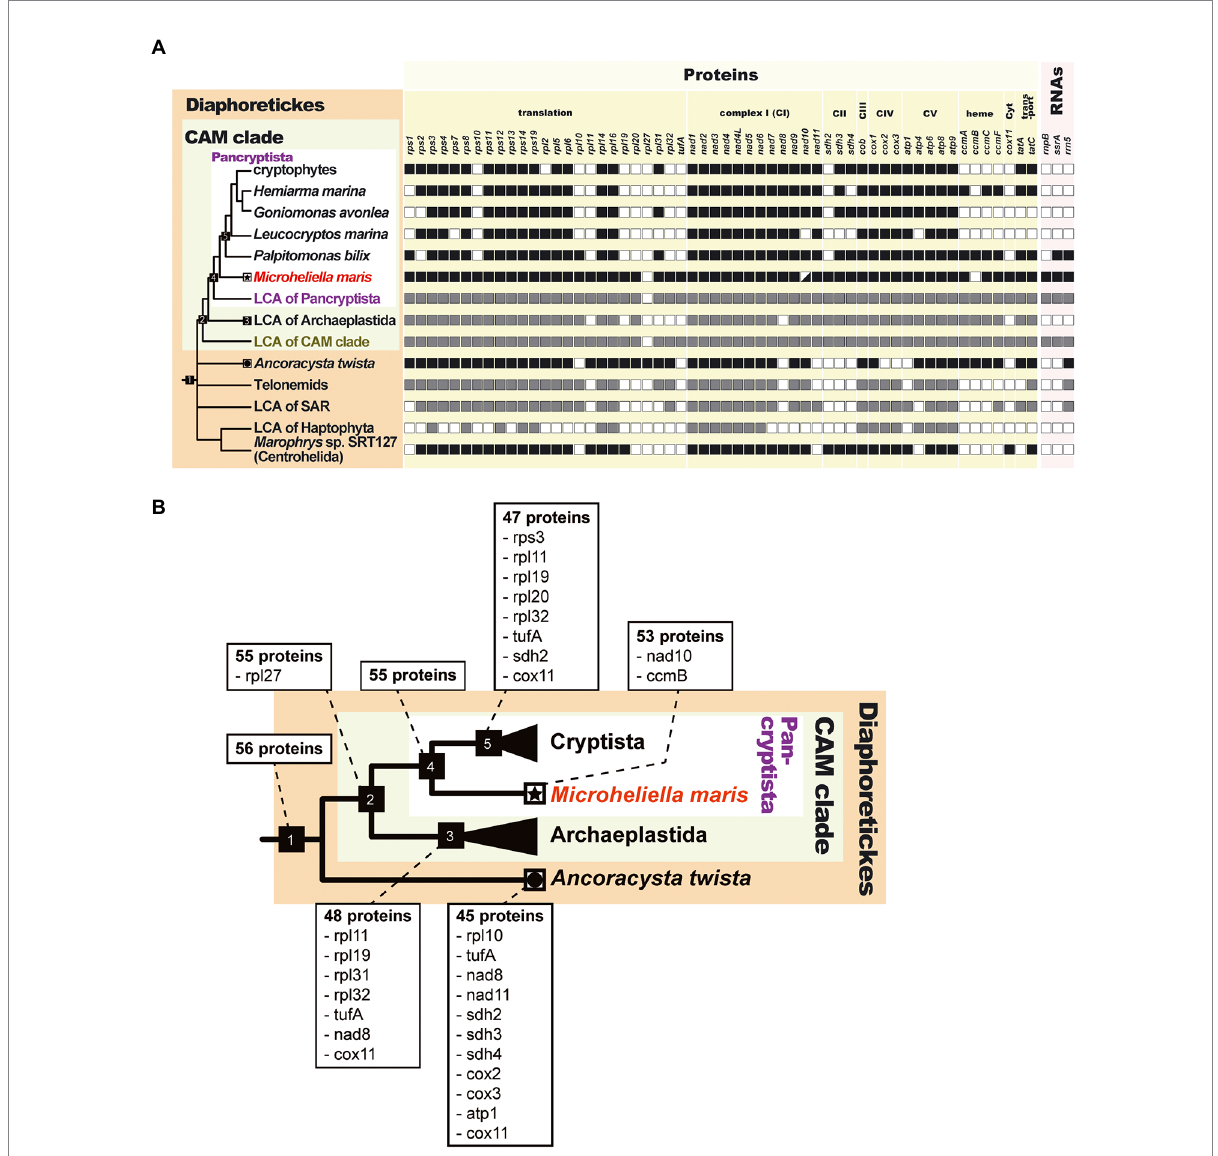
FIGURE 2 Evolution of mitochondrial genomes in Diaphoretickes. (A) Comparison of the gene contents of the mitochondrial genomes in Diaphoretickes. We only considered the genes containing functionally assignable open reading frames in this comparison. The presence and absence of genes in a mitochondrial genome are shown by closed and open squares, respectively. nad10 was absent in the mitochondrial genome but the corresponding transcript was detected in Microheliella maris (highlighted by a square with lower right half painted in black). The putative presence and absence of genes in the last common ancestors (LCAs) of Pancryptista, Archaeplastida, SAR, and Haptophyta are shown by gray and open squares, respectively. (B) Putative gene loss events during the mitochondrial genome evolution in Diaphoretickes. Only members of Pancryptista, Archaeplastida, and Ancoracysta twista with the second gene-rich mitochondrial genome among the member of Diaphoretickes, are depicted in this figure. For each node of interest, the putative number of genes and the gene/genes lost comparing to the previous node are indicated. Node 1, last common ancestor (LCA) of Diaphoretickes; node 2, LCA of CAM clade; node 3, LCA of Archaeplastida; node 4, LCA of Pancryptista; node 5, LCA of Cryptista. The terminal node for M. maris is labeled by a star. The 11 genes lost on the branch from the LCA of Diaphoretickes to A. twista are also shown in a shaded